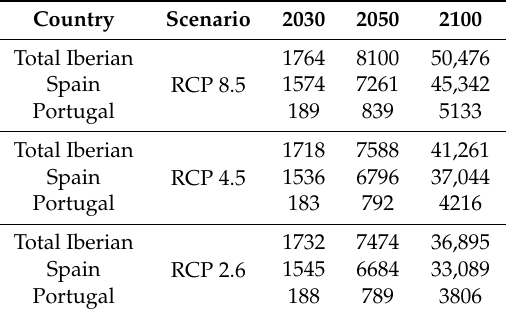
Table 3. Accumulated damage costs (million EUR) for 64 Iberian coastal cities, aggregated by